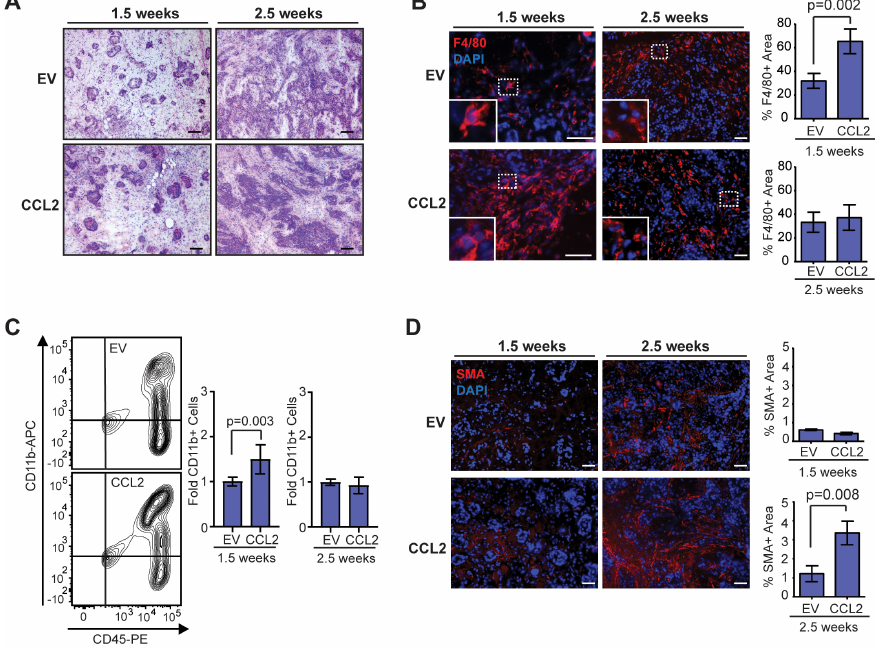
Figure 2. Stromal CCL2 overexpression in mouse mammary glands leads to time-dependent changes in the developing tumor microenvironment. ( A ) Representative H&E images of oncogenic epithelial cell growth at 1.5 and 2.5 weeks post-transplantation. ( B ) Percent area of F4/80 + macrophages in developing tumors at 1.5 and 2.5 weeks post-transplantation ( n = 4 tumors/group; Student’s t -test). ( C ) CD45 + CD11b + monocytes/macrophages in the mammary gland at 1.5 and 2.5 weeks post-transplantation were quantified by flow cytometry ( n = 5 EV, 7 CCL2, Mann–Whitney U test). ( D ) Percent area of SMA + cells in developing tumors at 1.5 and 2.5 weeks post-transplantation ( n = 4 tumors/group; Student’s t -test). Magnification bars = 50 µm.